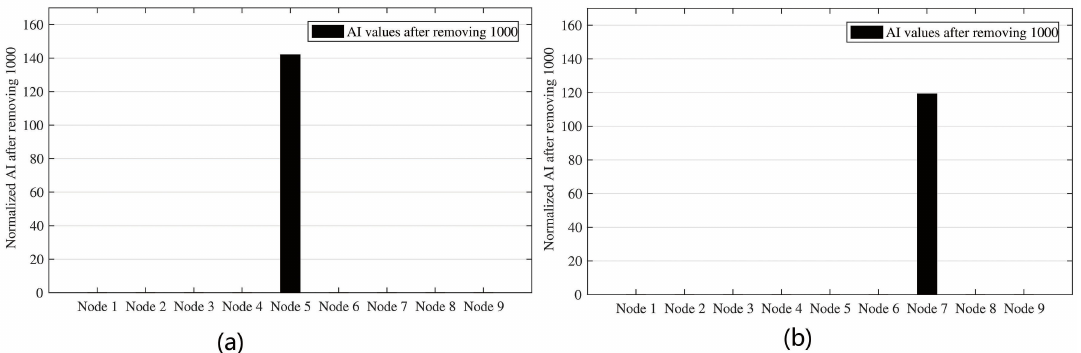
Figure 17. Distribution of AIs along the beams for all accelerometers assuming ( a ) Case N5D40 from beam model: delta = 40 at Node 5 and ( b ) Case N7D30 from beam model: delta = 30 at Node